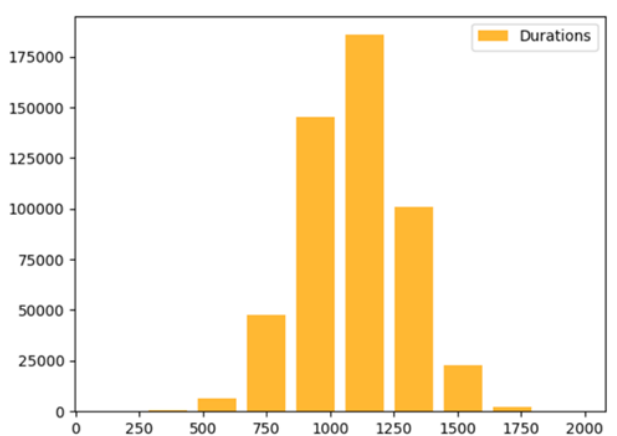
Figure 2. Example of a distribution of the durations of the intervals